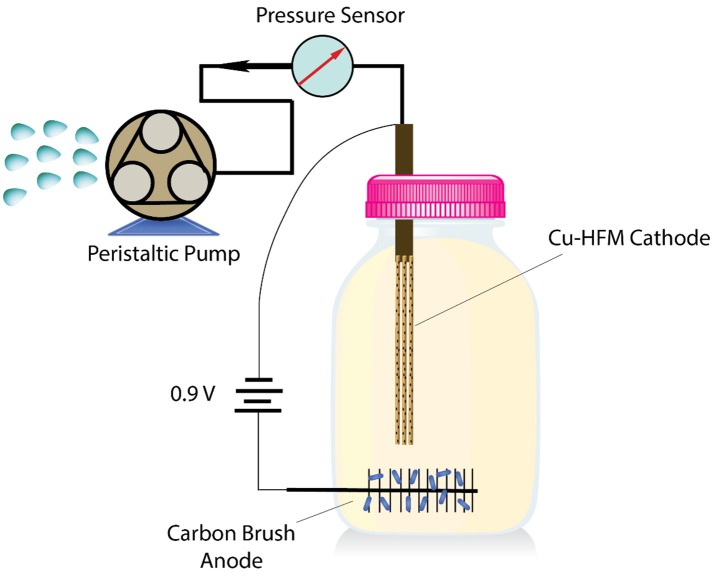
Schematic diagram of the EMBR system used in this study.